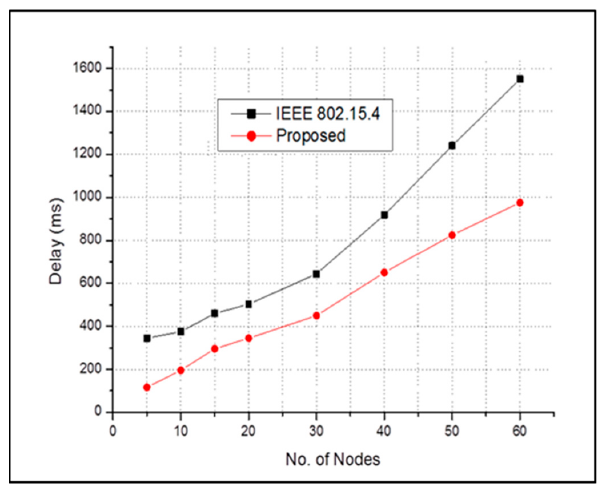
Figure 7. End-to-end average packet delay of all sensor nodes in case of emergency event.